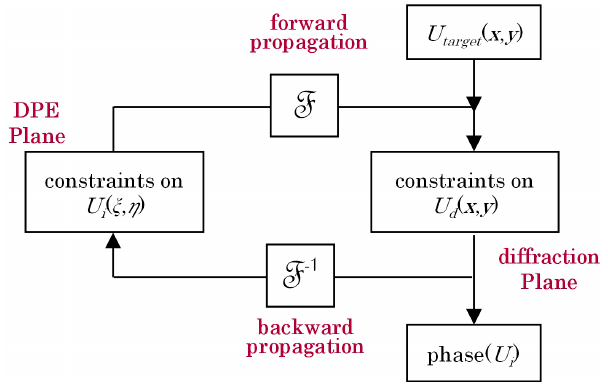
Figure 3. Schematic diagram of iterative Fourier transform algorithm (IFTA).